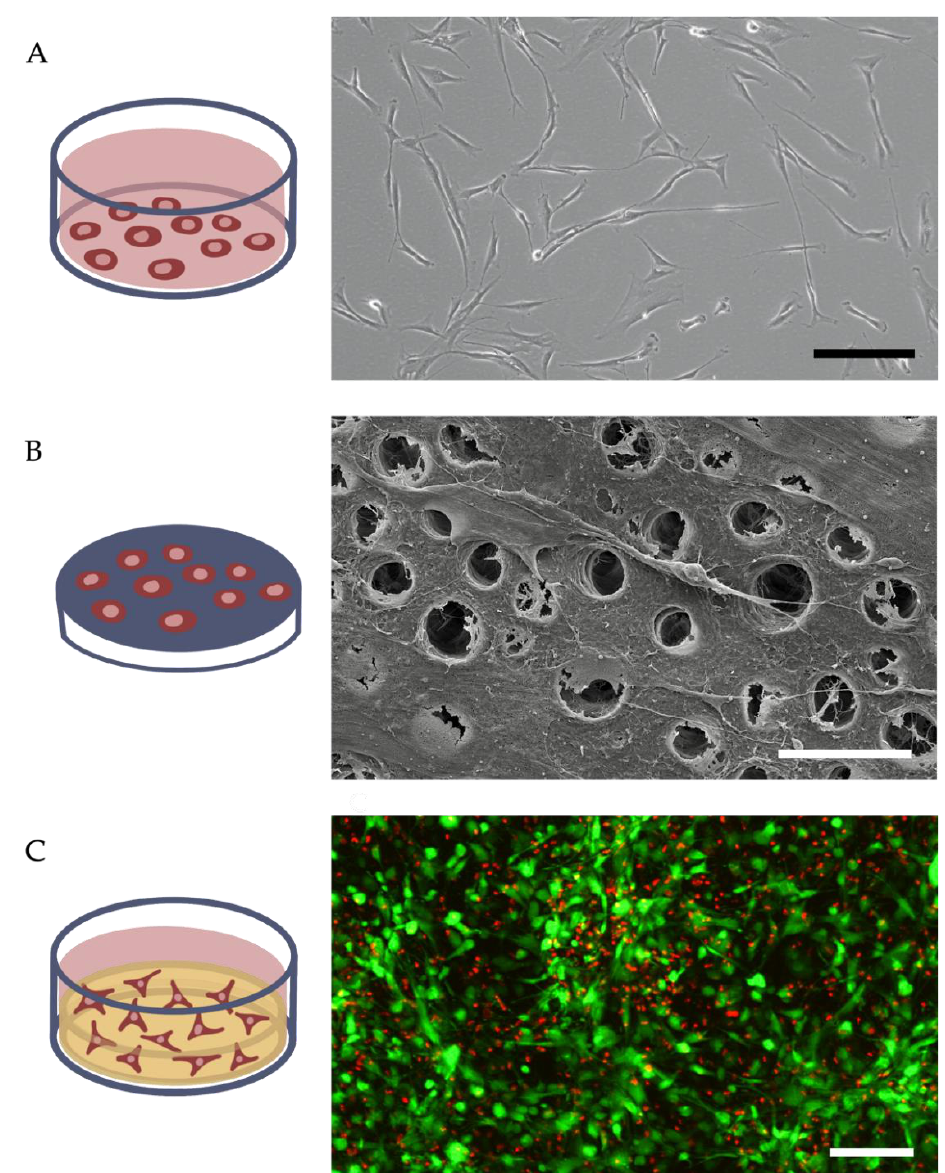
Figure 3. Comparison of morphologies of differently cultured cells. ( A ) DPSCs cultured on a tissue culture plate; scale bar of 200 µm. ( B ) REM image of DPSCs cultured on a dentin disk, where cells extend their processes into dentin tubules; scale bar of 10 µm. ( C ) Confocal laser scanning microscopy of live (green) and dead (red) DPSCs cultured in a collagen hydrogel shows the high turnover of cells; scale bar of 200 µm.